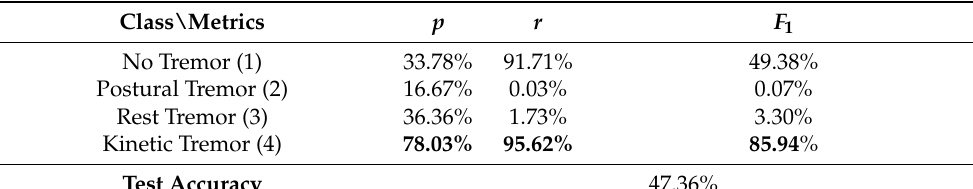
Table 10. Classification performance results computed on acceleration and gyroscope data: in the training phase, 16 bit sensors were used, and for the test phase, 8 bit sensors with 10% worse noise were simulated